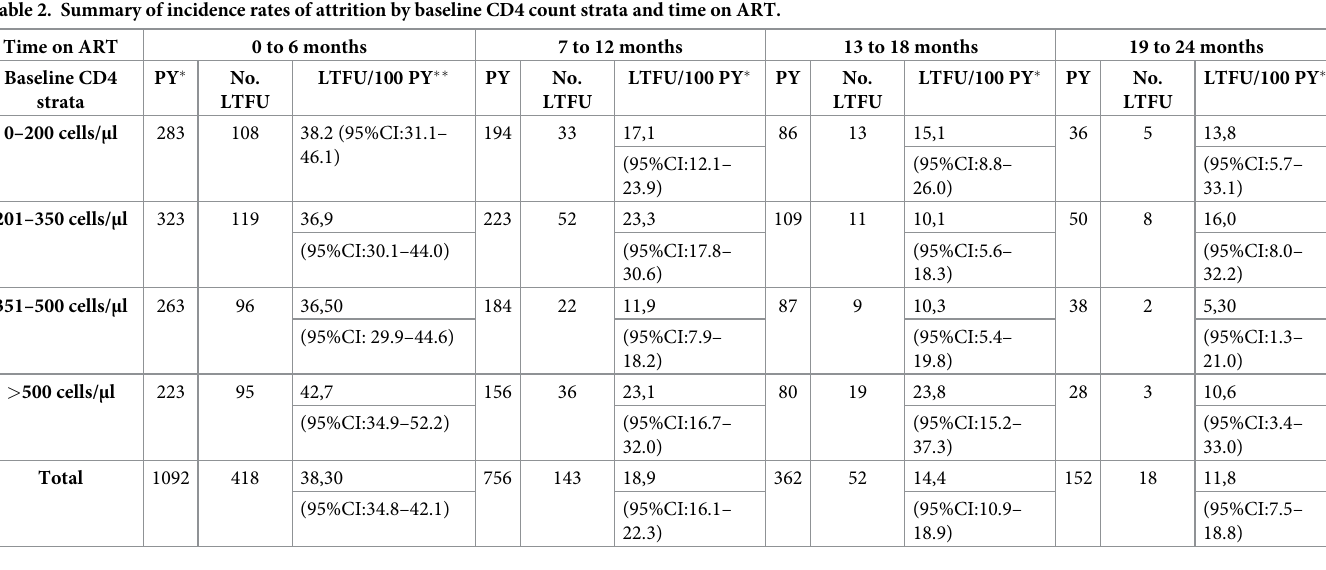
Table 2. Summary of incidence rates of attrition by baseline CD4 count strata and time on